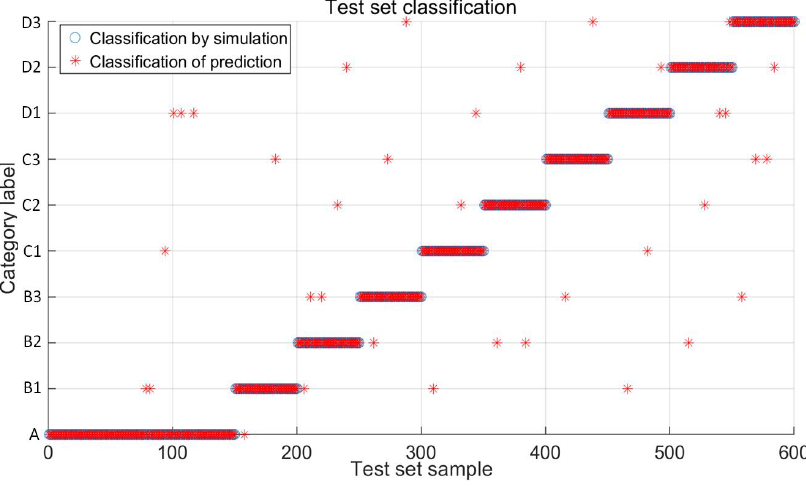
Figure 22. Diagnosis results.